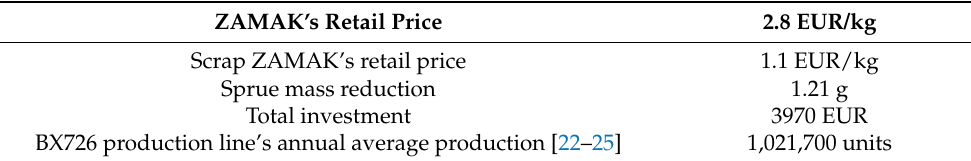
Table 1. Data used to calculate the saving achieved with the BX726 production line.